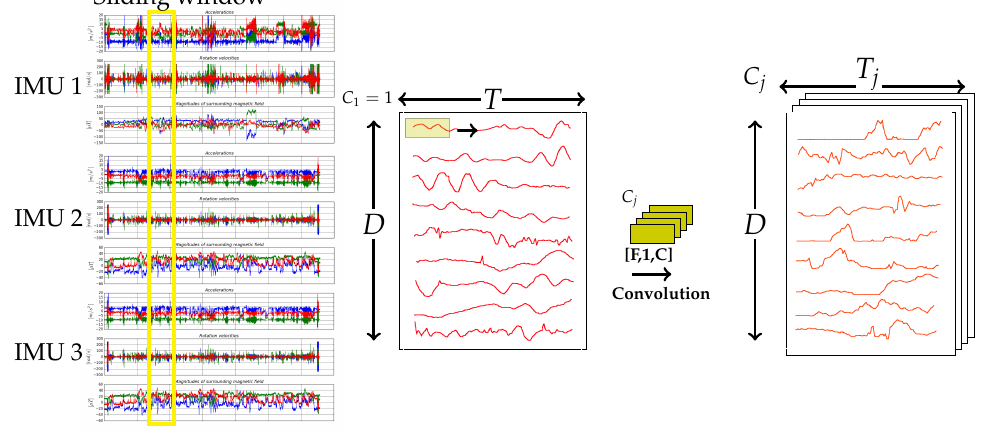
Figure 1. Example of IMUs’ measurements, a CNN’s input extracted following a sliding window approach, and a temporal convolution-operation in